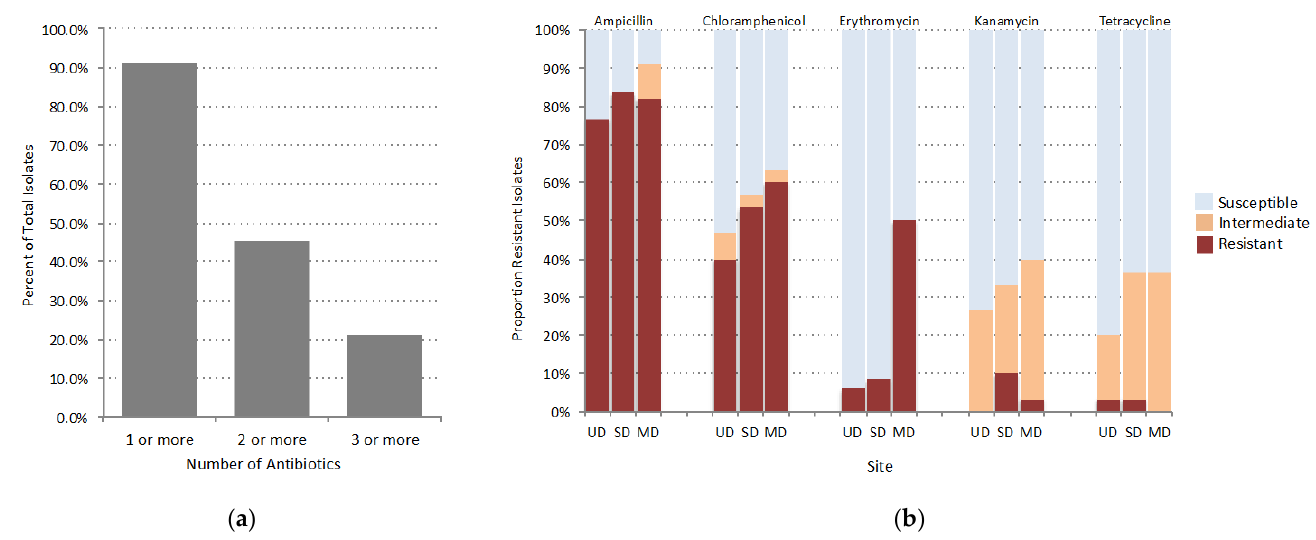
Figure 2. ( a ) Percent of total isolates with at least intermediate resistance to one or more, two or more, and three or more of the antibiotics tested. ( b ) Proportion of isolates at each FPES thaw site with the associated level of susceptibility (susceptible = light blue, intermediate = orange, resistant = red) to each antibiotic tested based on CLSI breakpoints.